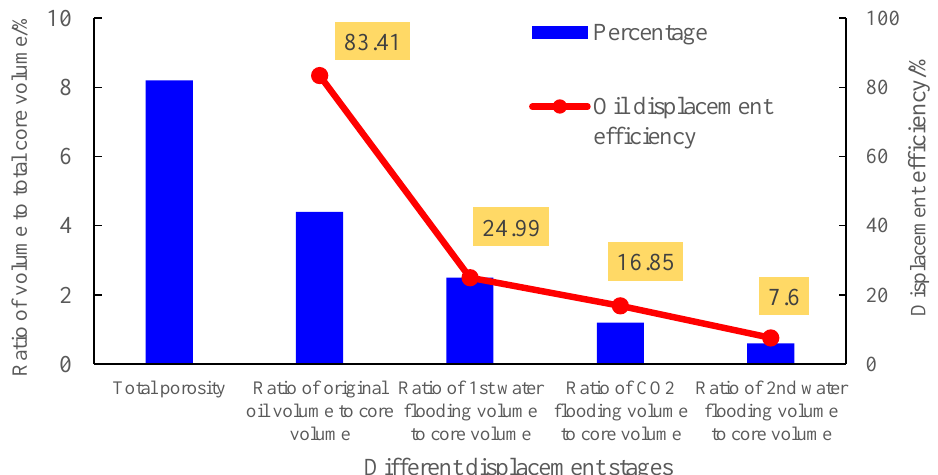
Figure 17. Displacement efficiency of the Y53–89 core and ratio of volume to total core volume in different stages.